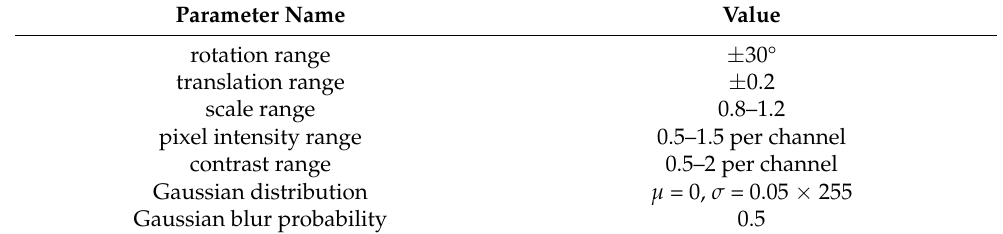
Table 1. Parameter setting of data augmentation.